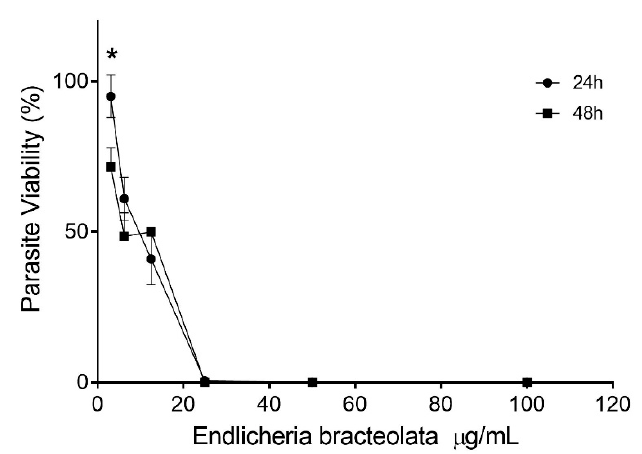
Figure 1. E ff ects of Endlicheria bracteolata essential oil on growth inhibition of Leishmania amazonensis promastigote forms. Data represents the mean ± error of three independent experiments carried out in triplicate. * p = 0.0168 when compared concentration treatment at di ff erent times by two-way ANOVA and Bonferroni’s multiple comparisons test. Table 2. Antileishmanial activity, cytotoxicity and selectivity index of Endlicheria bracteolata essential oil for 24 hours of treatment.